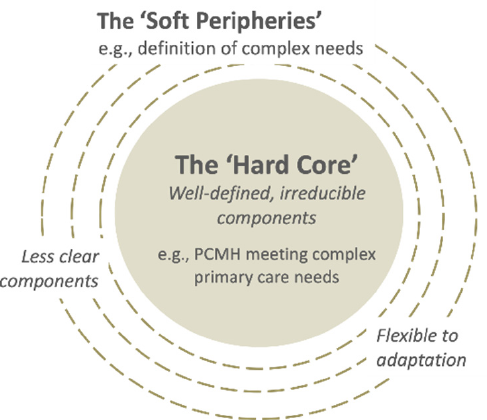
Figure 4. The “hard core” and the “soft peripheries” in a complex innovation. Adapted from [25].